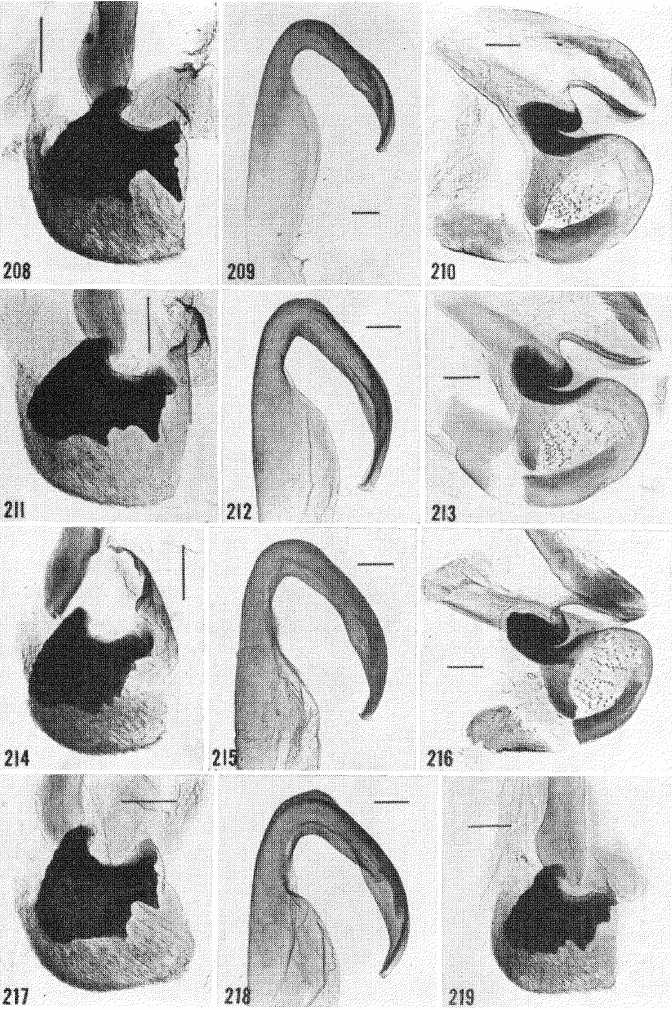
Figs. 208-219. Cockroach male genitalia. Epilampra columbiana. 208- 210. (4-9 ANSP). 211-213. (138 USNM). Barro Colorado Island, Panama (det. Roth). 214-216. (98 USNM). Sierra Campana, Panama (det. Gurney). 217-218. (137 USNM). Barro Colorado Island, Panama (det. Roth). 219. (154 USNM). La Campana, Panama (det. Roth). (scale 0.2